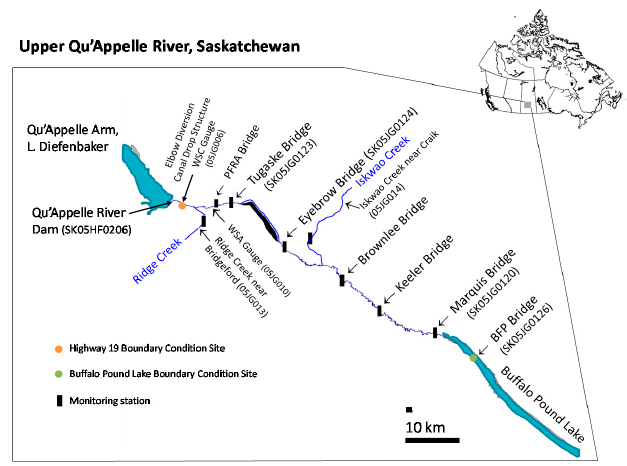
Figure 1. Map of the upper Qu’Appelle River. The lower Qu’Appelle River flows out of Buffalo Pound Lake.